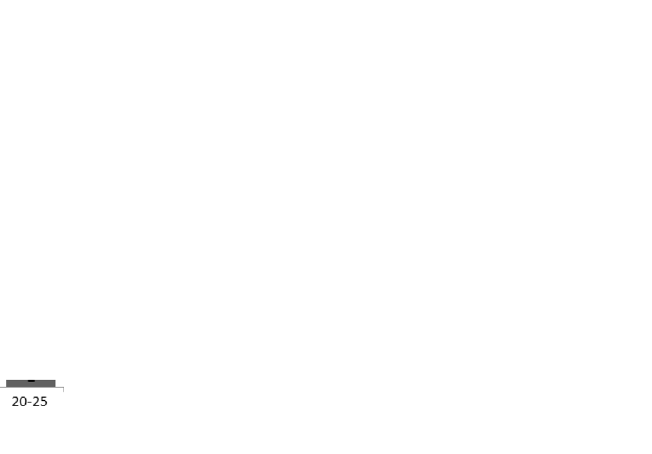
Figure 6. The micrograph of AgNPs synthesized by reduction of silver nitrate with the cell filtrate of Aspergillus sywdoii .